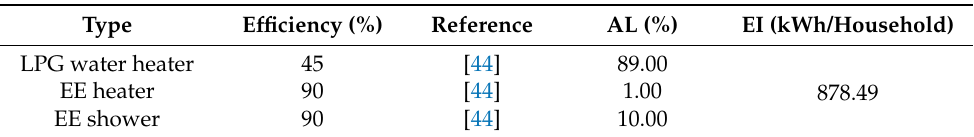
Table 11. Information required for the LEAP Cuenca, residential, DHW model. Saturation: 94% [28]. AL: 107,598 households.